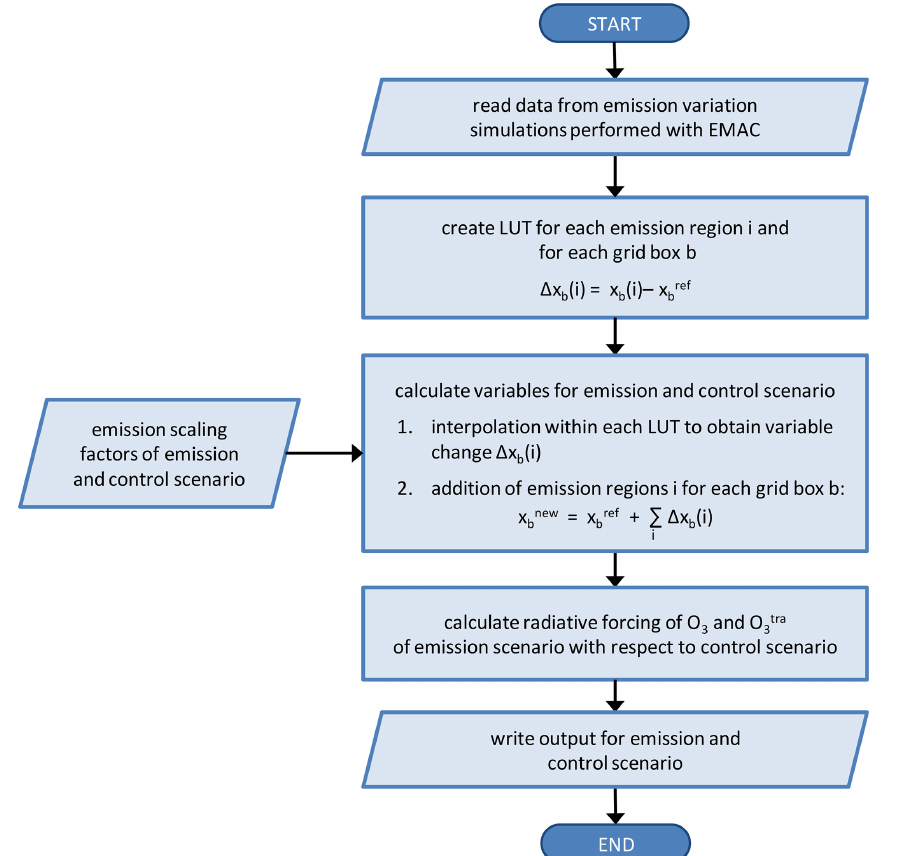
Figure 4. Workflow of TransClim showing the main calculation steps. For a defined emission and control scenario, TransClim computes the resulting climate effect such as the stratosphere-adjusted radiative forcing at the top of the